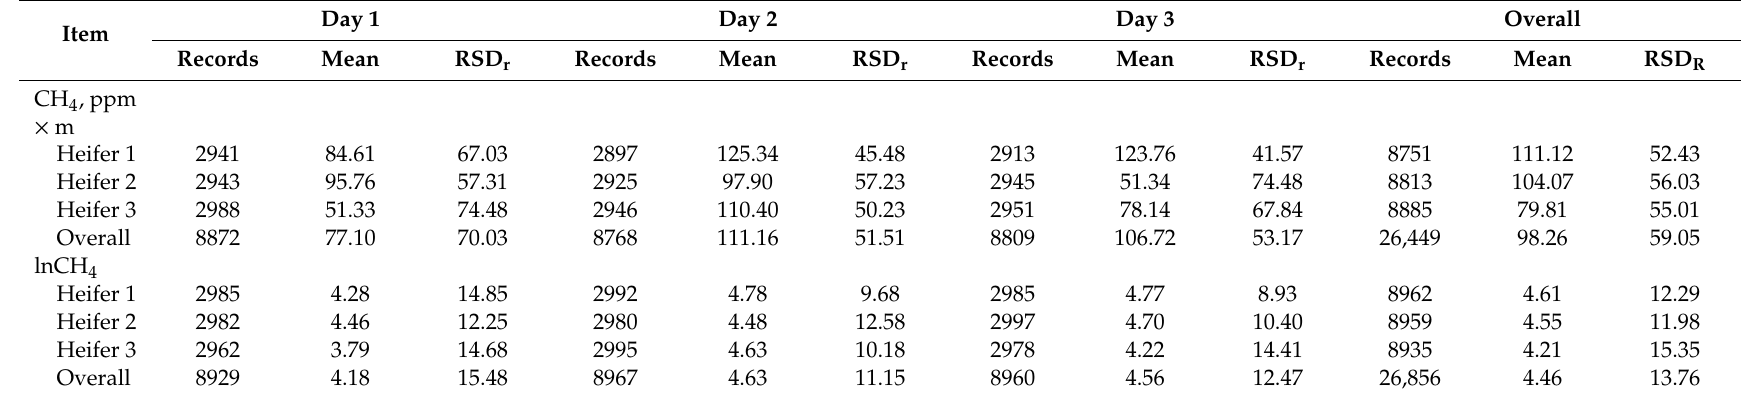
Table 2. Number of records, mean, repeatability relative standard deviation (RSD r , %) calculated within the day on five measurements, and reproducibility relative standard deviation (RSD R , %) calculated across days on 15 measurements for methane (CH 4 ) and log e -transformed methane (lnCH 4 ) emissions.